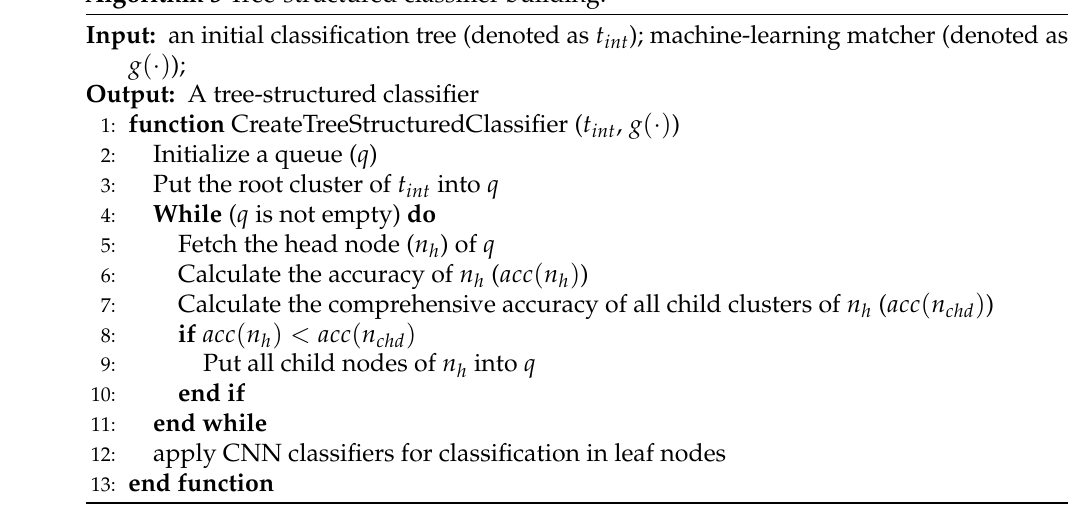
Algorithm 3 Tree-structured classifier